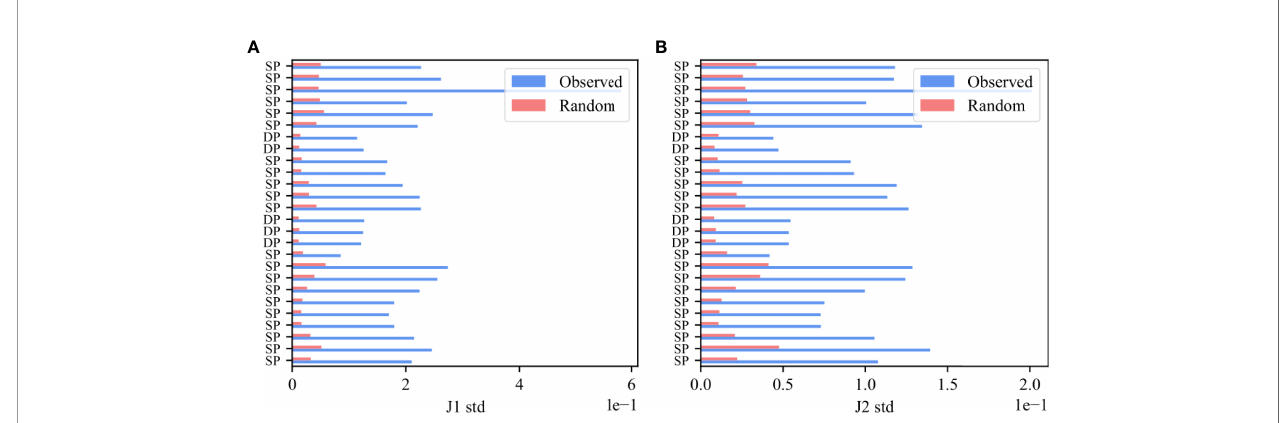
FIGURE 6 | Bias in Double Positive samples in mice thymocytes. The standard deviation of M ( V b , J b ) values for the J b 1 family gene (A) and for the J b 2 family gene (B) . The blue bars describe the F clones values and the pink bars represent the